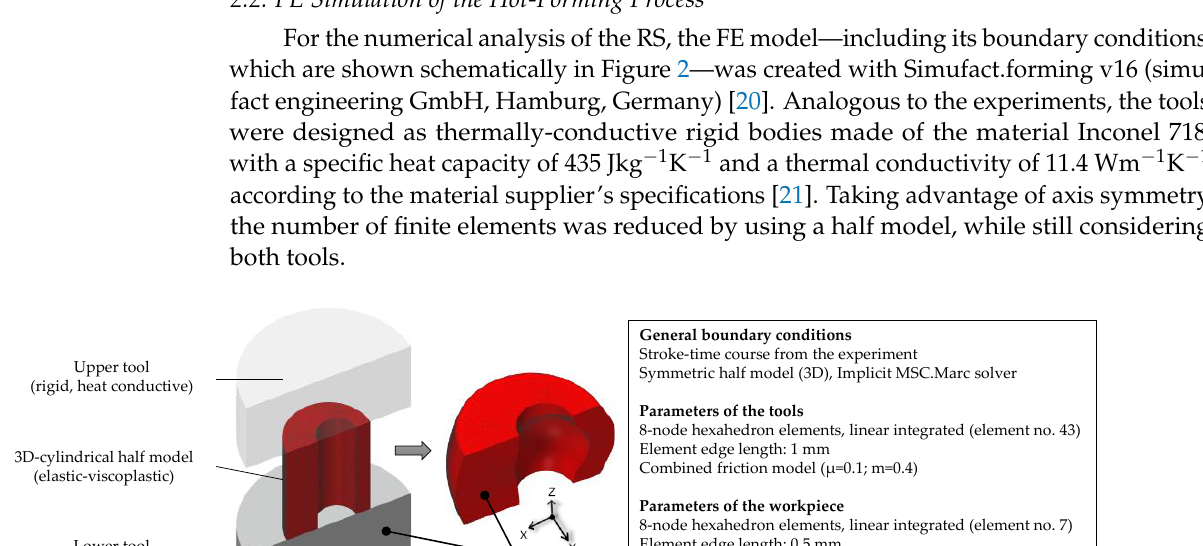
General boundary conditions Stroke-time course from the experiment Symmetric half model (3D), ImplicitMSC.Marc solver Parameters of the tools 8-node hexahedron elements, linear integrated (element no. 43) Element edge length: 1 mm Combined friction model (µ=0.1; m=0.4) Parameters of the workpiece 8-node hexahedron elements, linear integrated (element no. 7) Element edge length: 0.5 mm Initial condition of microstructure: 100 % austenite Symmetry plane